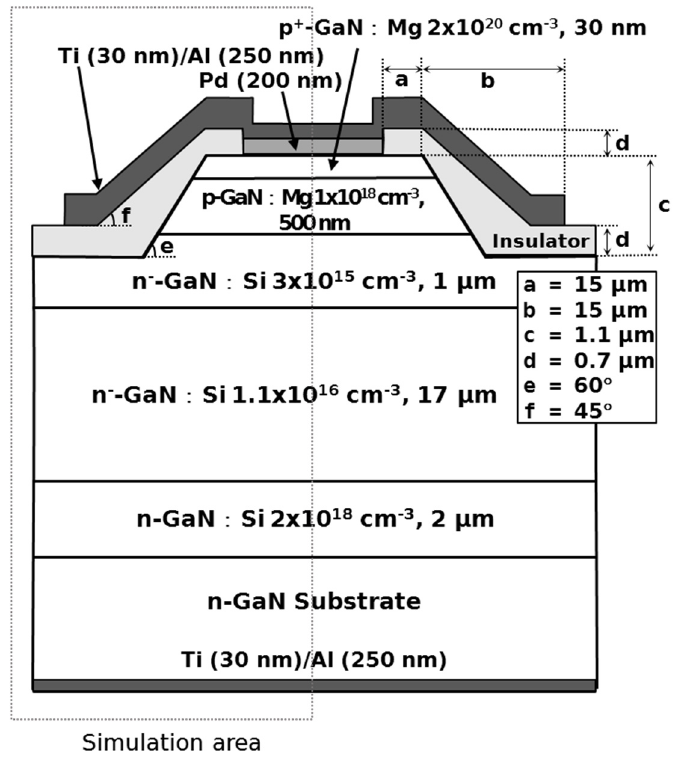
Figure 1. Schematic cross-section of GaN p-n junction diode with field plate termination.